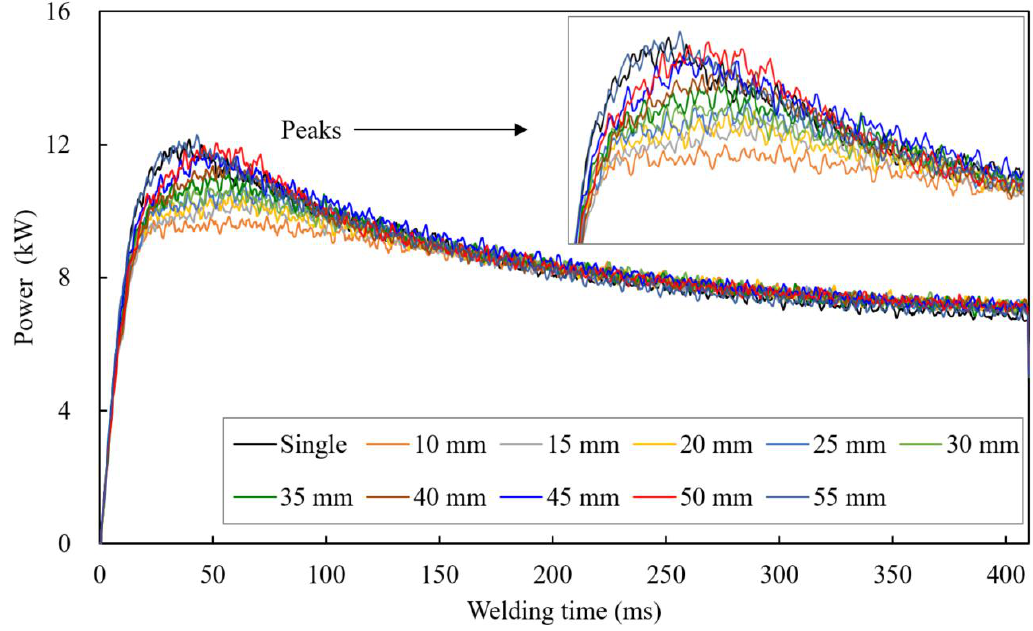
Figure 8. Welding power over time for various weld pitches under a constant 7.5 kA welding current, a 410 ms welding time, and a 3.5 kN electrode force (reference welding conditions).